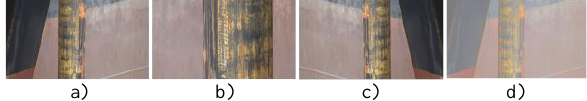
Figure 7. Data augmentation: a) original image; b) Zoom in; c) horizontal mirror; and d) brightness transformation.